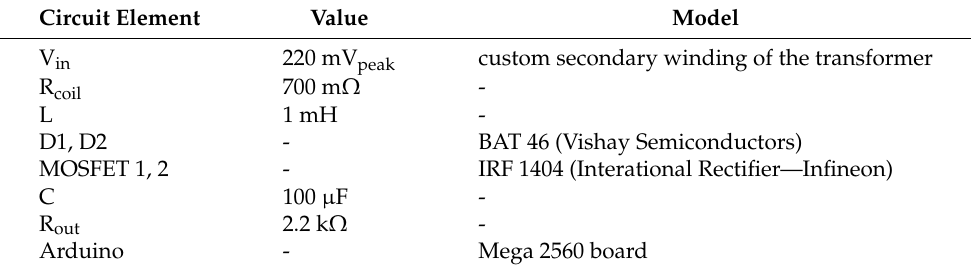
Table 1. Electrical Parameter Values of the Circuit shown in Figure